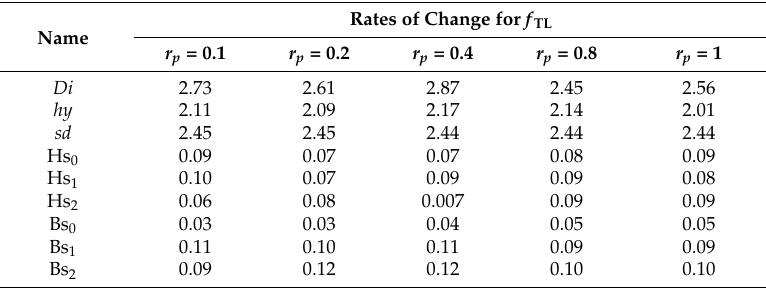
Table 4. Sensitivity analysis of the